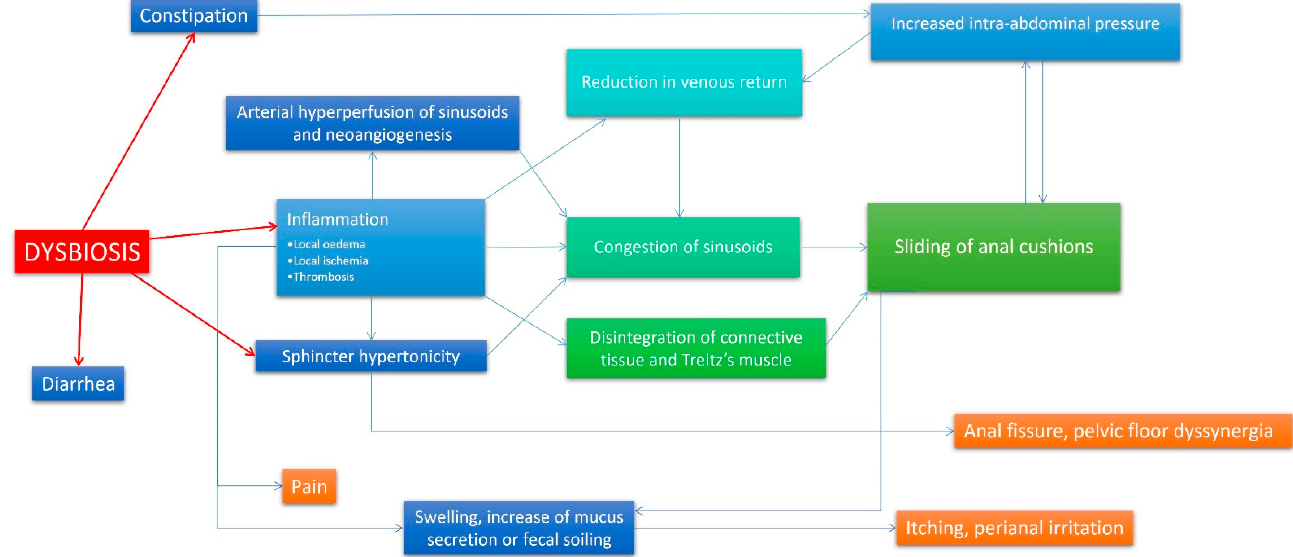
Figure 2. A new theory on haemorrhoidal disease pathophysiology. In this flow-chart, a new model of haemorrhoidal disease pathophysiology mechanism is presented. In this case, dysbiosis is the primum movens of the disease, and events that lead to symptoms are the direct effect of the